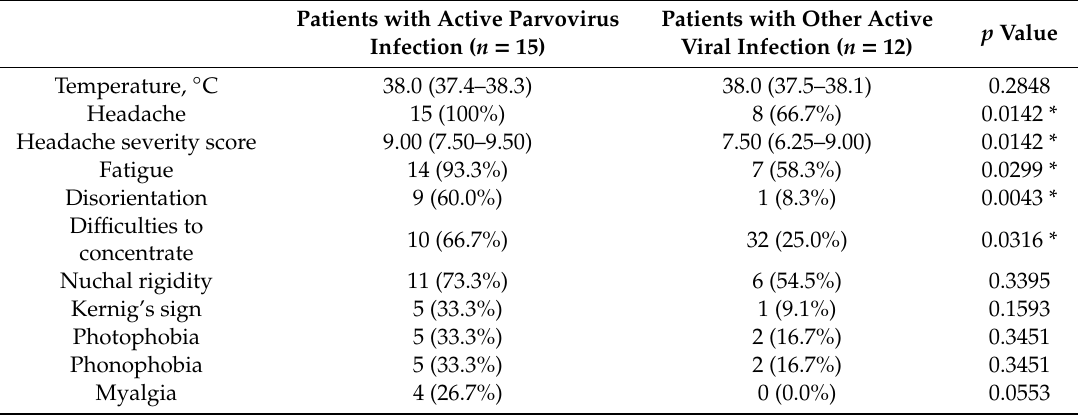
Table 4. Clinical features of the study population by cause of active